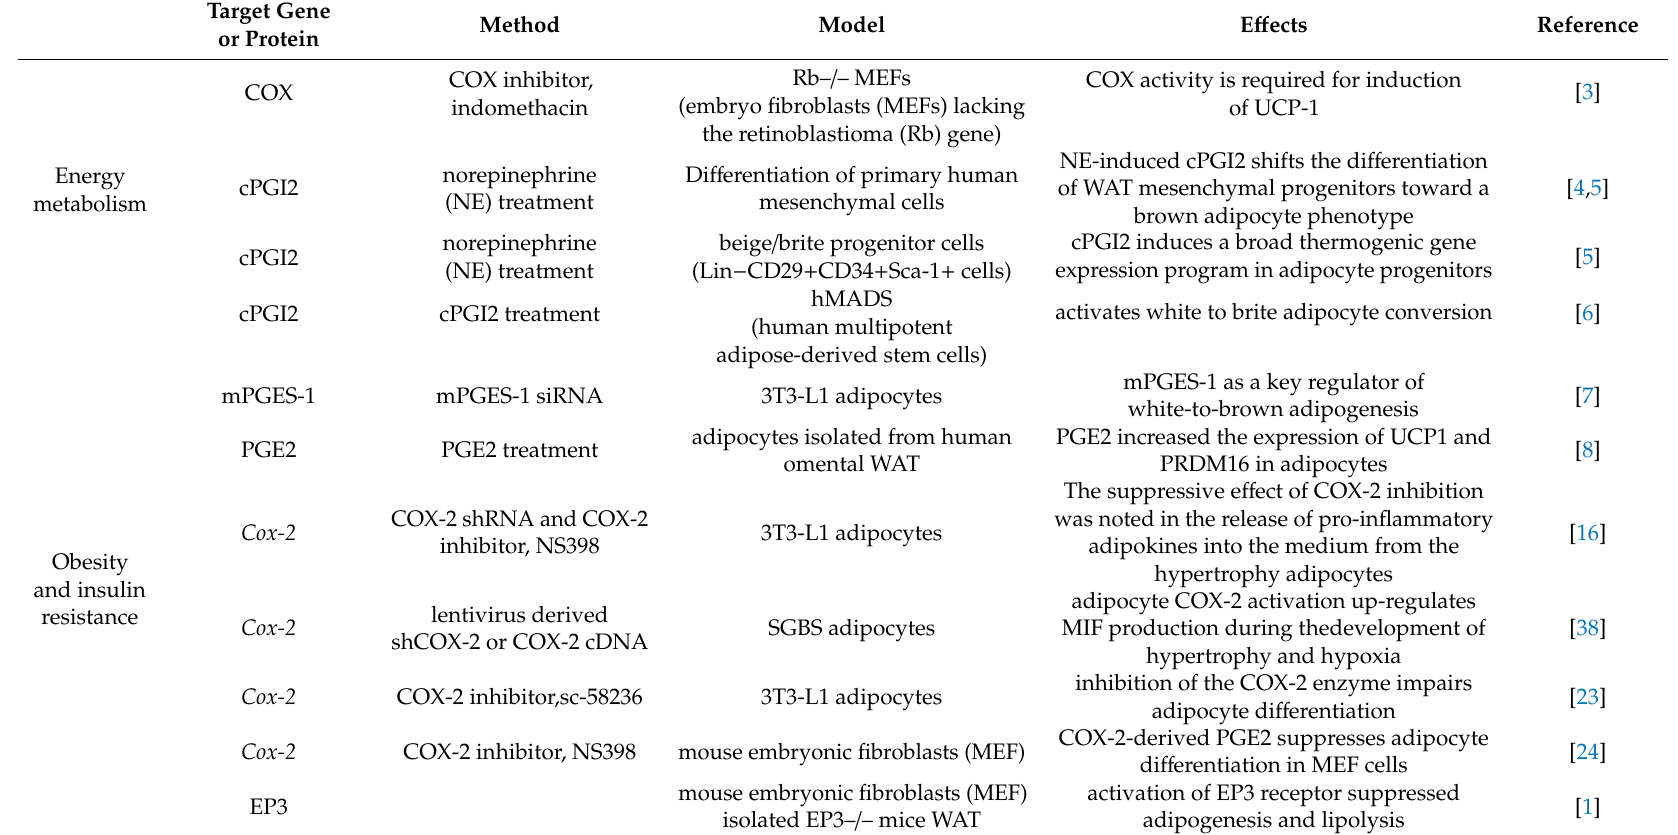
Table 2. Overview of in vitro studies targeting COX-2-mediated signaling